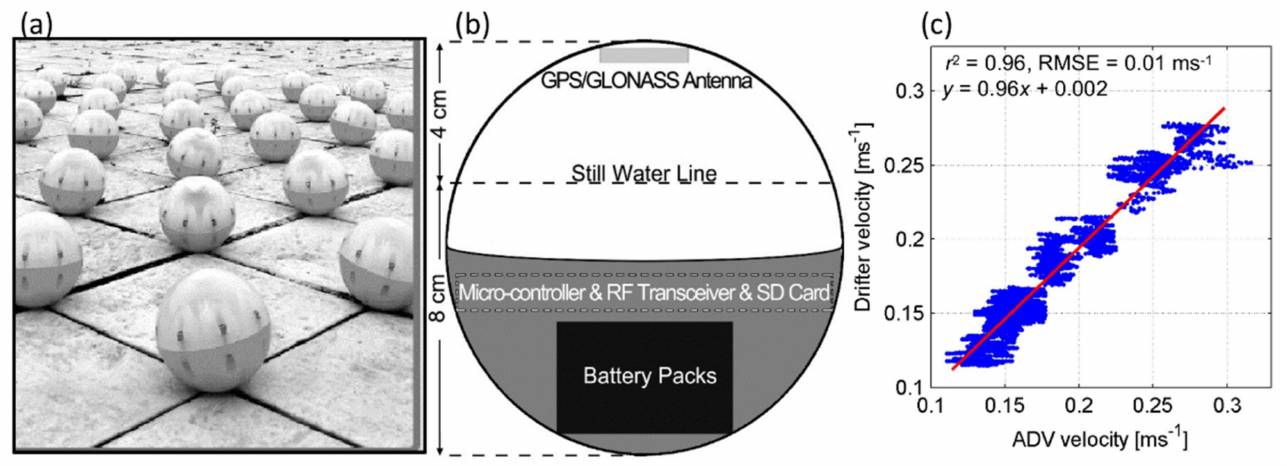
Figure 1. Self-developed sea-surface drifter: ( a ) photo, and ( b ) structure. ( c ) Measurements of flow velocities using the sea-surface drifters versus simultaneous acoustic doppler velocimeter measurements in a water